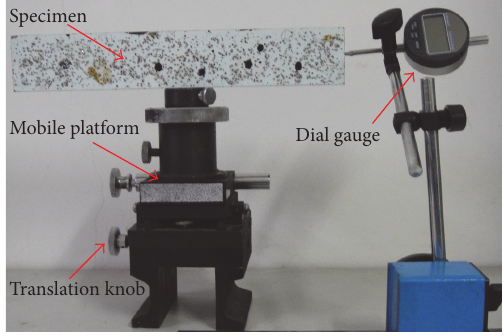
Figure 3: Experimental photo.